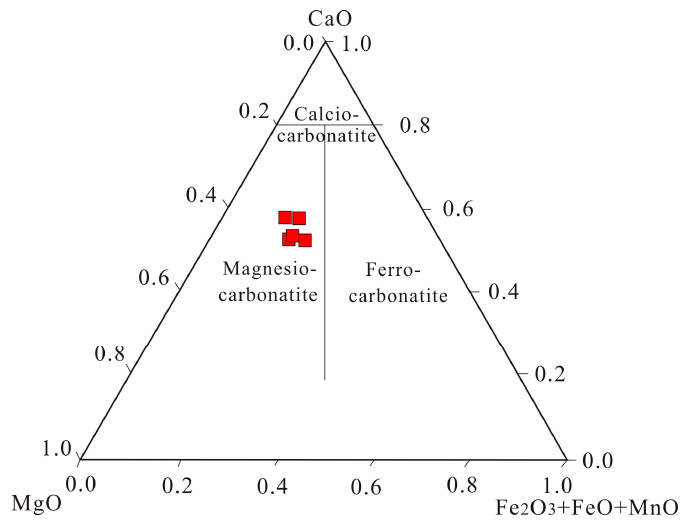
Figure 5. Classification diagram of CaO-MgO-(Fe 2 O 3 + FeO + MnO) for samples from the Dol-dyke (after [38]).